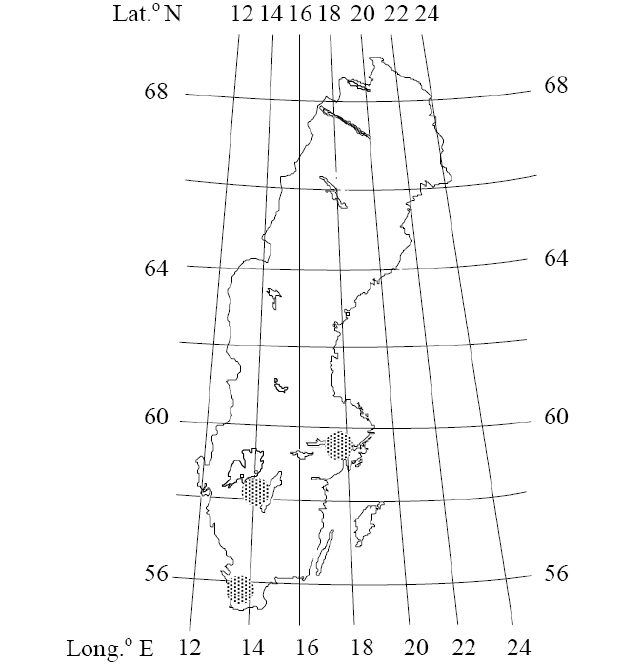
Figure 1. Locations of the study sites, all on abandoned farmland in Sweden.